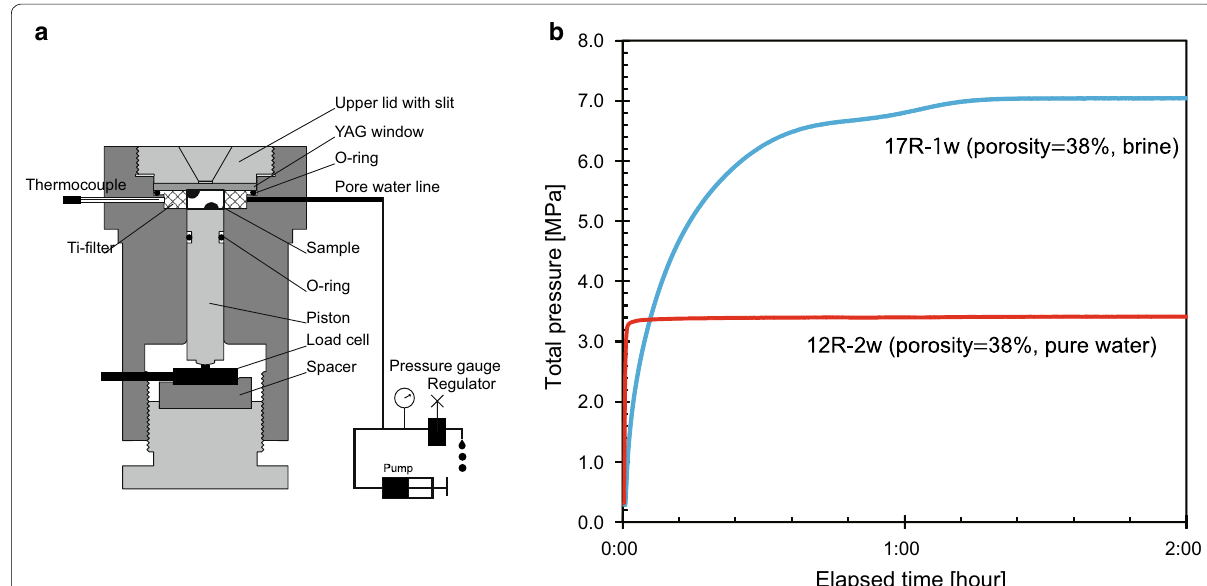
Fig. 2 Apparatus and typical results of the swelling pressure tests. a Schematic diagram of the test apparatus used in this study. b Typical swelling pressure measurements for the fault zone sample (blue line) and the host rock sample (red line). Note that the fluid pressure was fixed at 0.2